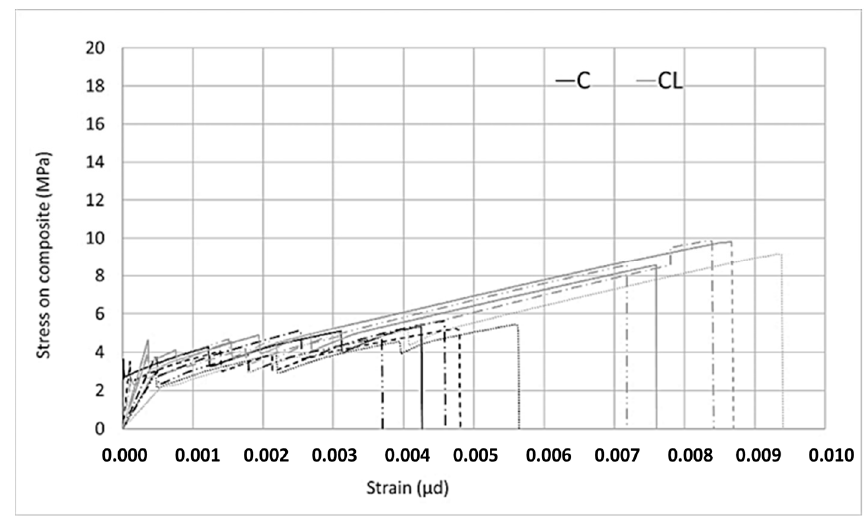
Figure 6. Stress on the composite–strain relationship of the M60 composite.